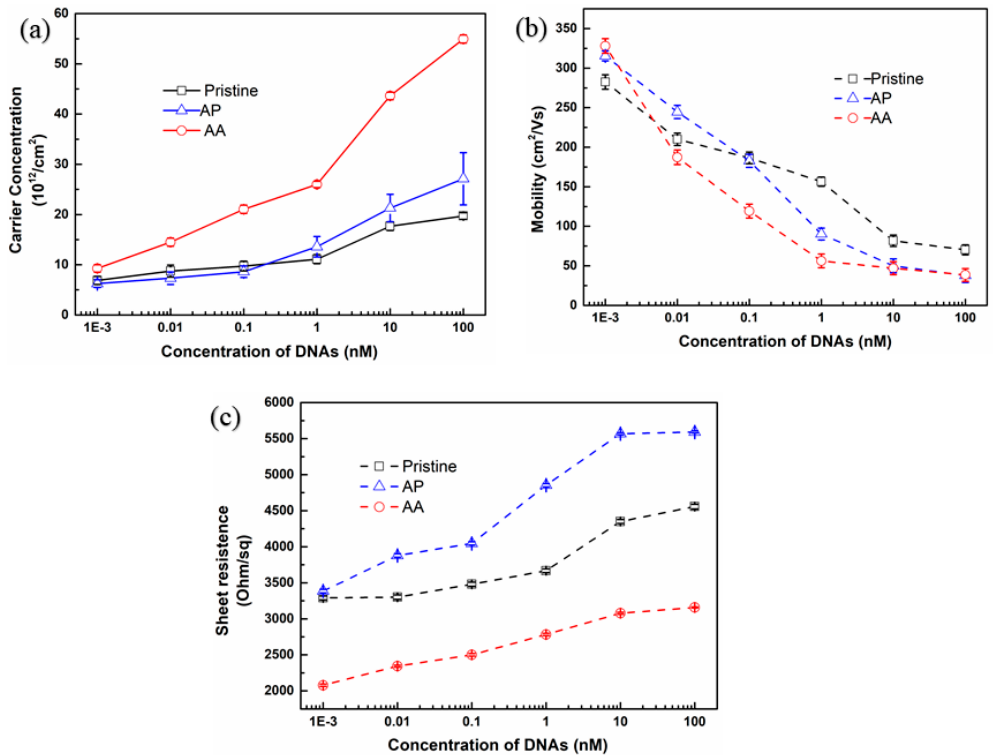
Figure 9. The electrical performance of three kinds graphene-based biosensors for the detection of target DNA: ( a ) carrier concentration; ( b ) mobility; ( c ) sheet resistance.